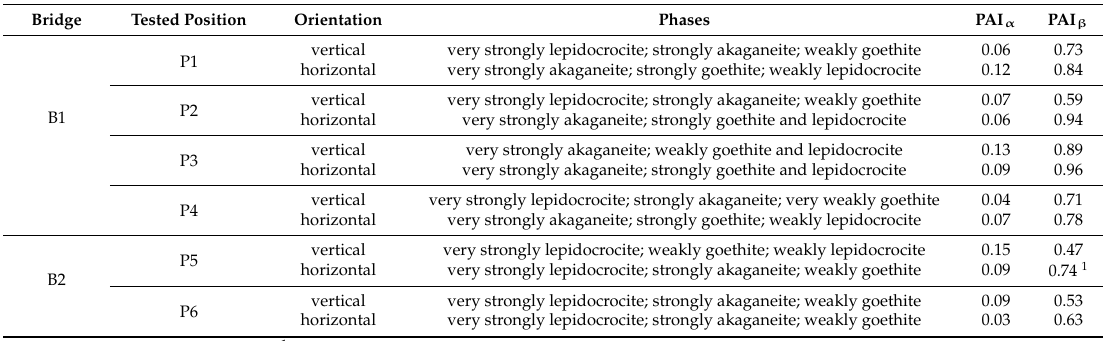
Table 6. Phases analysis of corrosion